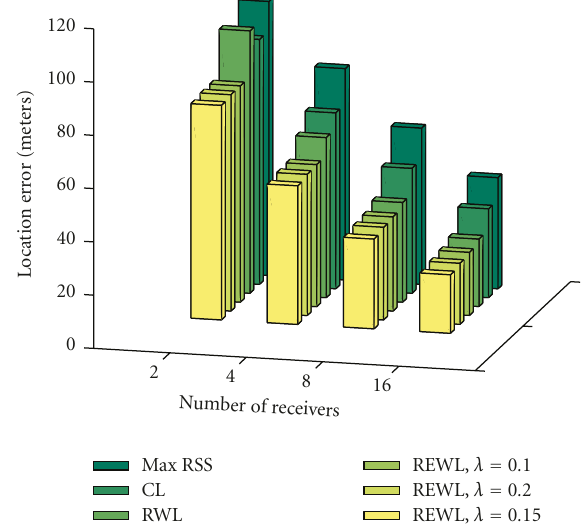
Figure 5: Algorithm location error by number of receivers for